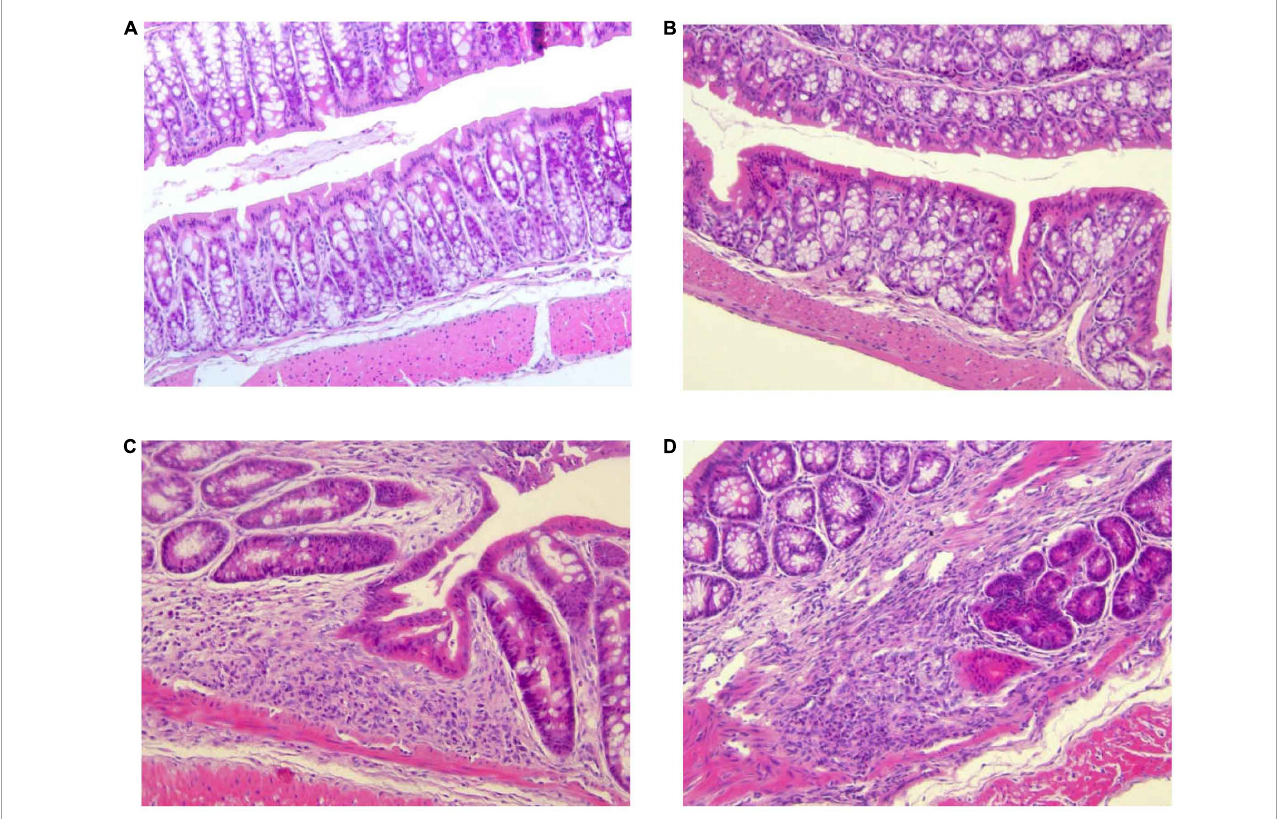
FIGURE4 Differences in histological parameters during experimental colitis induced by DSS. Colon was collected at day 38 from mice of G1 (A) , G2 (B) , G3 (C) , and G4 (D) . Colonic sections were stained with hematoxylin and eosin and representative images were captured at 20 × magnification. DSS treated mice are G3 and G4